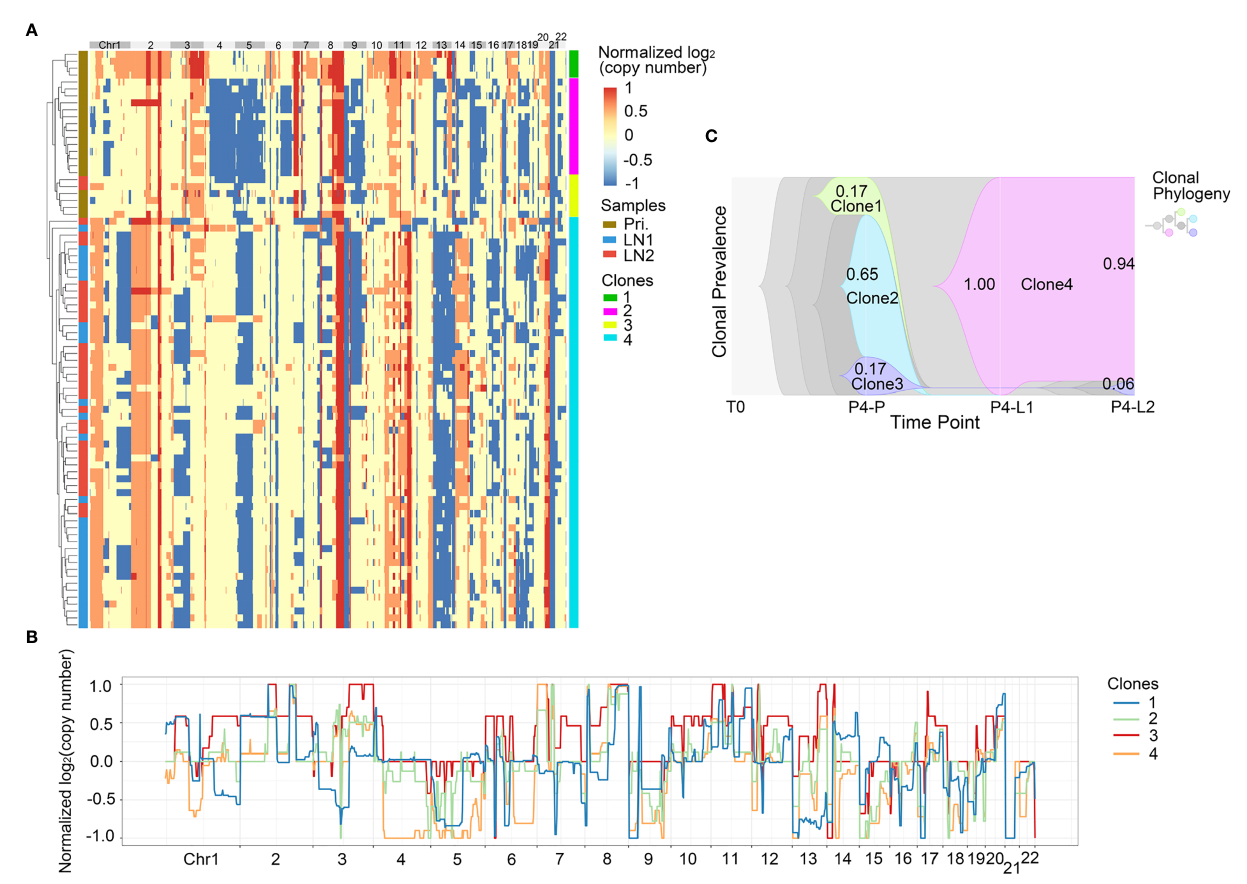
FIGURE 5 | CNV heterogeneity and clonal evolution analysis of primary tumor and lymph nodes in Pt.4. (A) A heatmap of single cell copy number pro fi les in Pt.4 with the clustering analysis based on CNVs on the left. All the cells were divided into four subclones. (B) A plot showed the normalized average copy numbers of the four subclones in Pt.4. (C) The clonal evolution from primary to L1 and L2 with the clonal prevalence changes indicated in